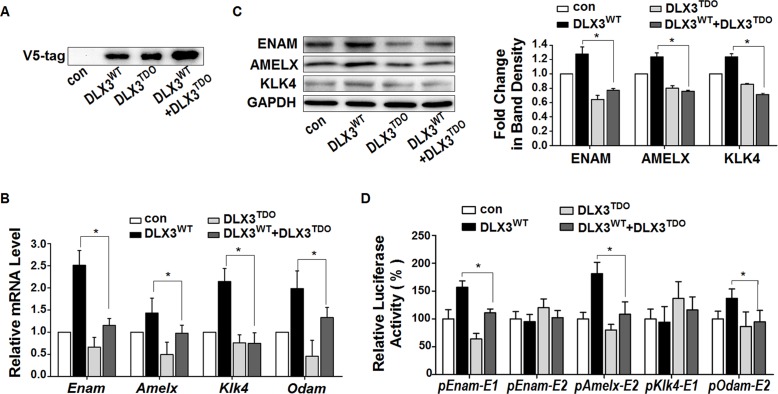
TDO mutation of DLX3 inhibits the activation of EMP genes by wild-type DLX3.(A) The plasmids pCI-neo (control empty vector, con), V5DLX3WT, and V5DLX3TDO were transfected into LS8 cells. Equal amounts of V5DLX3WT or V5DLX3TDO plasmid were added to each group, and the total amounts of plasmid in the groups were kept constant using pCI-neo. Over-expression of V5DLX3WT or/and V5DLX3TDO were analyzed by western blot using antibody against V5-tag. A representative figure from three independent experiments is shown. (B) After over-expression, the mRNA expression levels of Enam, Amelx, Klk4, and Odam were evaluated. Values were obtained from three independent experiments, and are presented as mean ± SD. *P <0.05 between the DLX3WT group and the DLX3WT+DLX3TDO group. (C) Left panel: western blot for the protein expression levels of ENAM, AMELX, and KLK4 after transfection (representative of three independent experiments). Right panel: densitometric analysis of images of 3 independent experiments. *P <0.05 between the DLX3WT group and the DLX3WT+DLX3TDO group. (D) After co-transfection with pCI-neo (empty control vector), V5DLX3WT, V5DLX3TDO, or both V5DLX3WT and V5DLX3TDO plasmids, the relative transcriptional activity of the 5 reporter constructs containing potential DLX3 response elements were analyzed by luciferase assays. Data were compared with the control group (con), and are presented as mean% ± SD. *P <0.05 between the DLX3WT group and the DLX3WT+DLX3TDO group. pEnam-E1 represents pGLEnam-E1, etc.